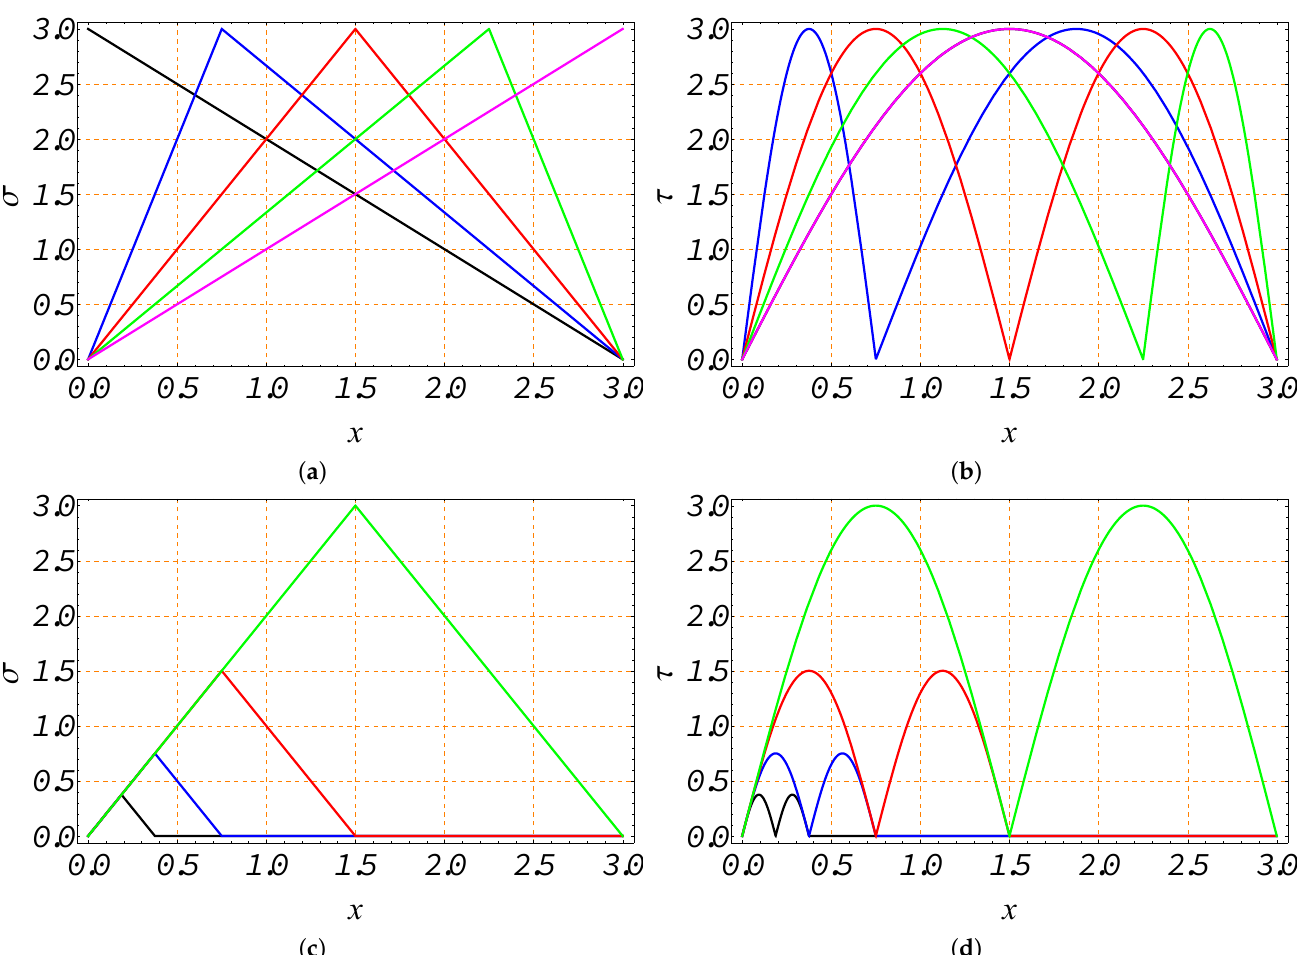
Figure 1. Chaotic maps are applied to x ∈ ( 0, α ) with α = 3.0. ( a ) STM and ( b ) FC with µ = 0 (black), µ = 0.25 α (blue), µ = 0.50 α (red), µ = 0.75 α (green), and µ = α (magenta). ( c ) STM and ( d ) FC with µ = 0.5 α and α = 0.375 (black), α = 0.75 (blue), α = 1.5 (red), and α = 3.0